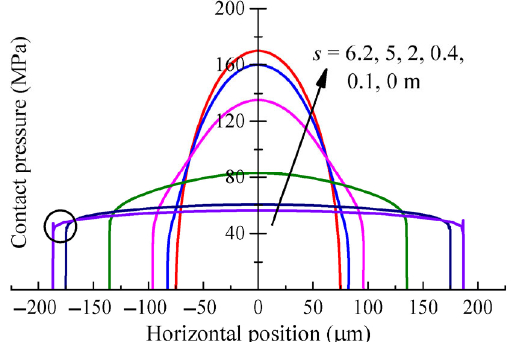
Fig. 7 Predicted evolution of contact pressure with increasing sliding distance s .